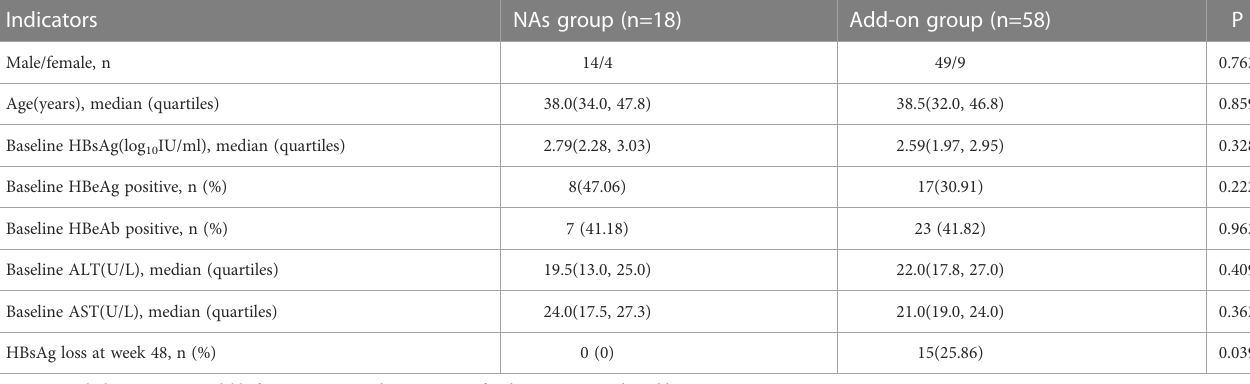
HBeAg/HBeAb data were not available for one patient in the NAs group, for three patients in the Add-on group. Abbreviations: NAs, nucleos(t)ide analogs; Add-on, nucleos(t)ide analogs combined with pegylated-interferon-alpha; HBsAg, hepatitis B surface antigen; HBeAg, hepatitis B e antigen; HBeAb, hepatitis B e antibody; ALT, alanine aminotransferase; AST, aspartate amino